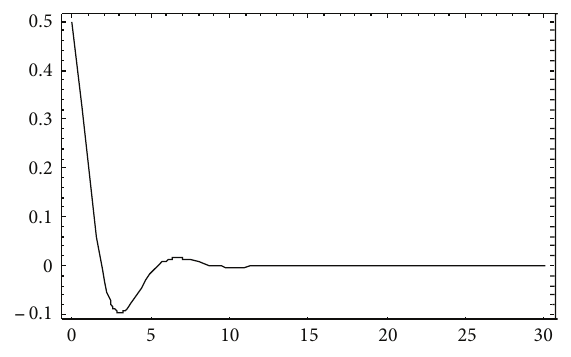
Figure 6: Time series analysis of e 2 ( f